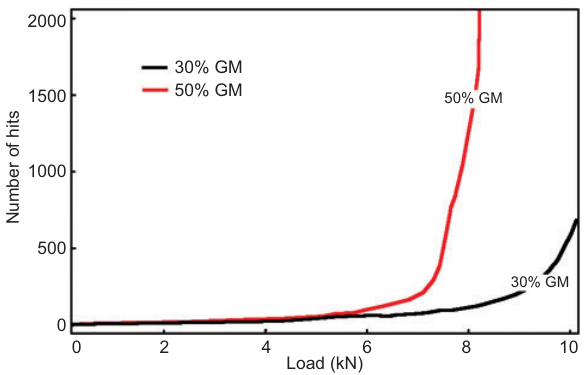
Figure 14 Acoustic emission activity of MS3 and MS4 [number of hits vs. load (kN/10)].